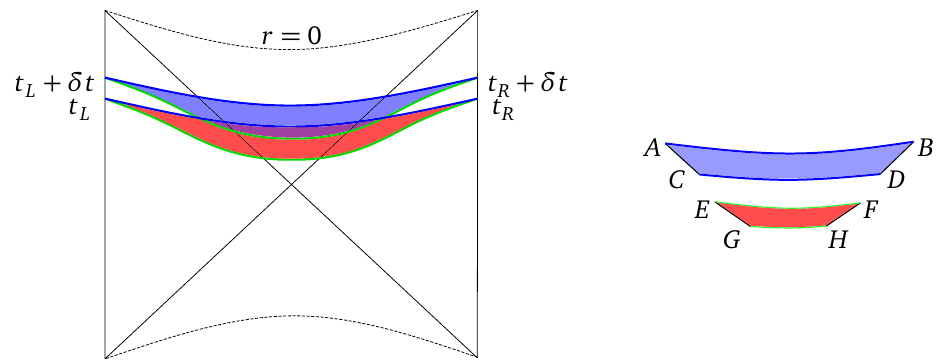
Figure 10: Growth of action in the BTZ black hole between constant curvature sur- faces (blue) and maximal volume surfaces